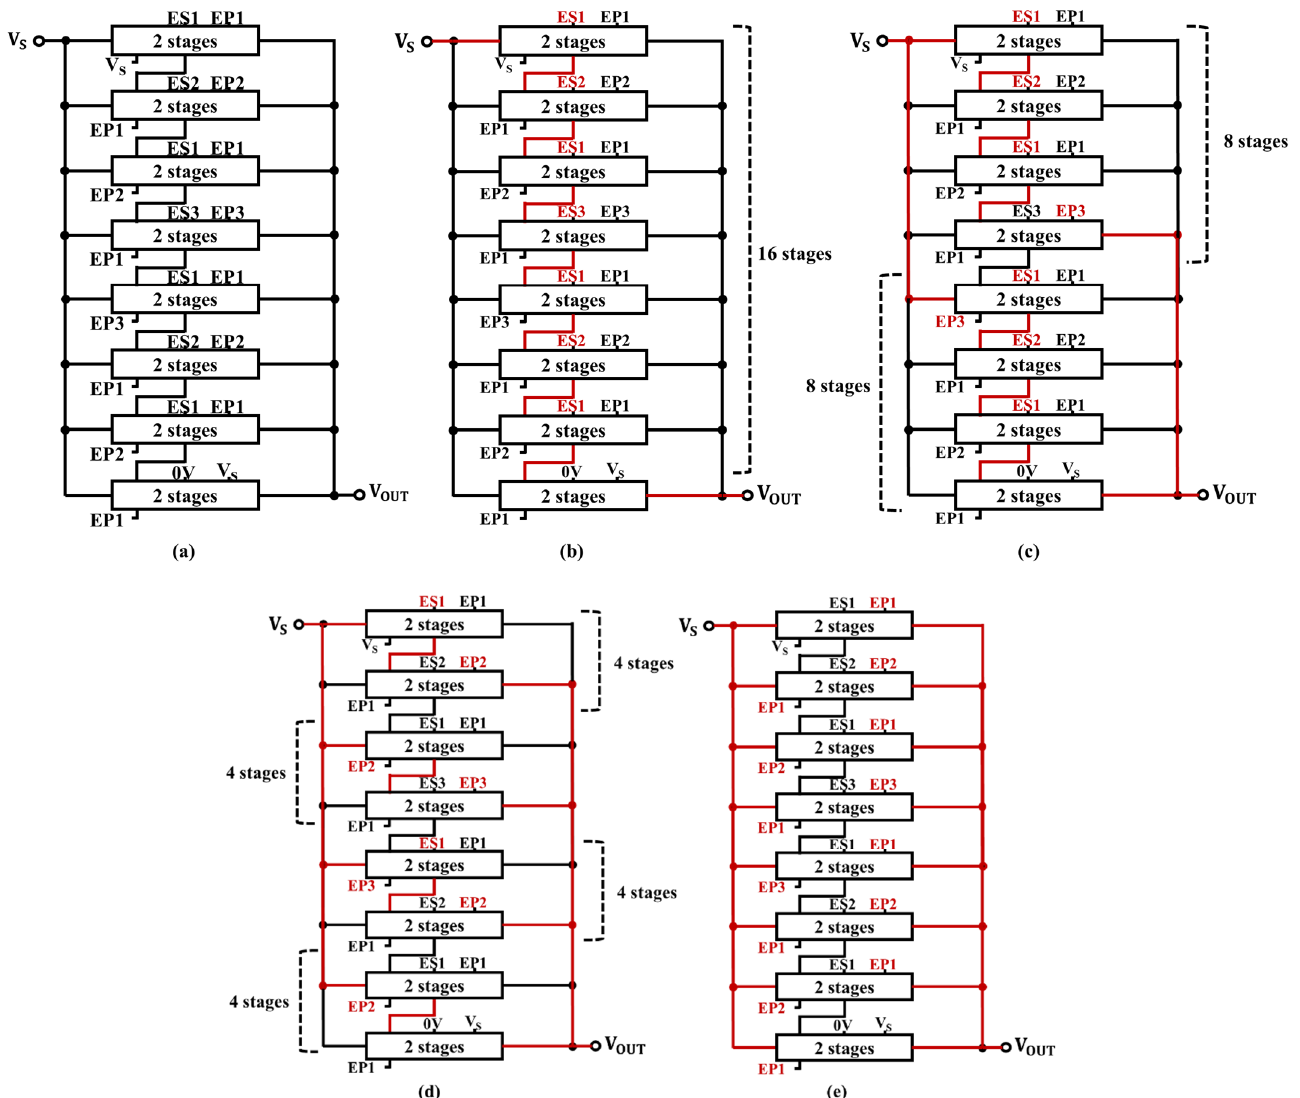
Figure 9. ( a ) Reconfigurable CP, ( b ) single-array 16-stage mode, ( c ) two-array eight-stage mode, ( d ) four array four-stage mode, ( e ) eight-array two-stage mode.